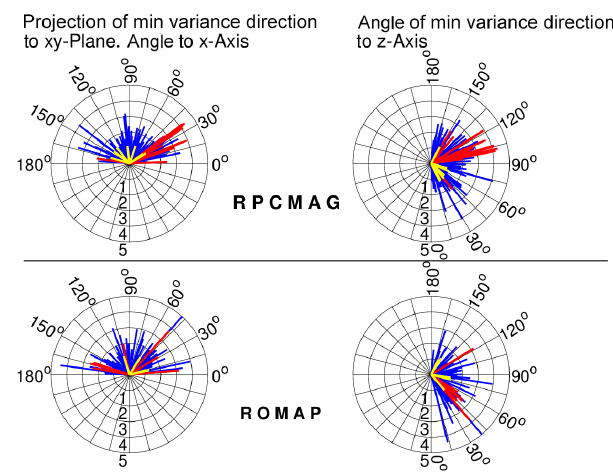
Figure 16. Distribution of minimum variance directions derived from RPCMAG (top) and ROMAP (bottom) data for the complete descent. Colour coding – blue: all MVA results, red: elliptical/more complex polarization ( λ max /λ med ≥ 2 and λ med /λ min ≥ 3), yel- low: circular polarization ( λ max /λ med ≤ 1 . 3 and λ med /λ min ≥ 3). The radial component represents the eigenvalue